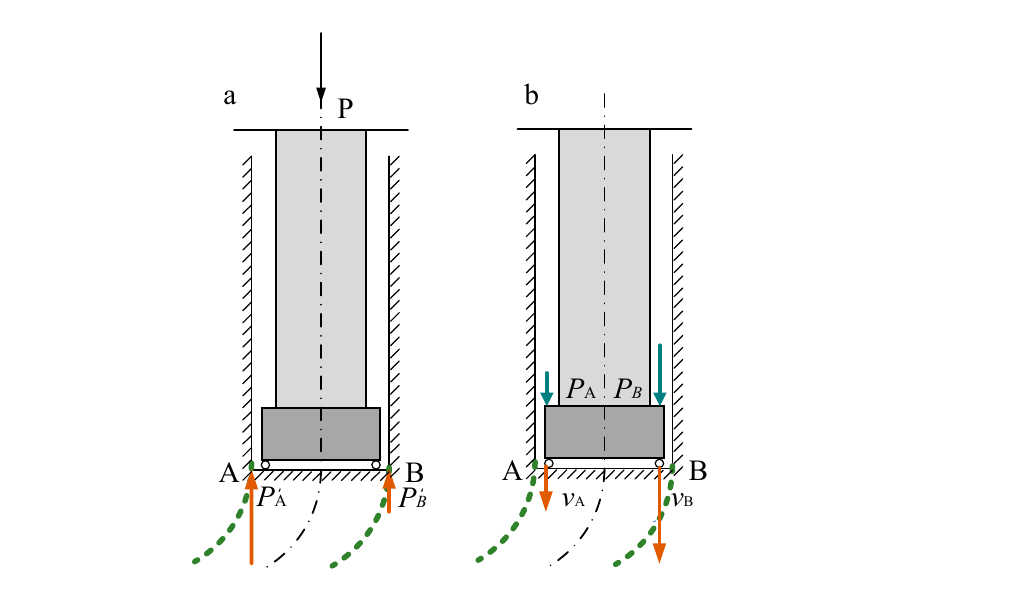
Figure 10. Drilling axis deviation caused by drilling speed difference due to unbalanced force on bit lip. ( a )—Different rock breaking resistance at the bottom of the hole results in the difference of drilling rate, P (cid:2885)(cid:4593) > P (cid:2886)(cid:4593) . ( b )—Different axial pressure on the bit lip results in the differential of drilling rate, P (cid:2886) > P (cid:2885) .